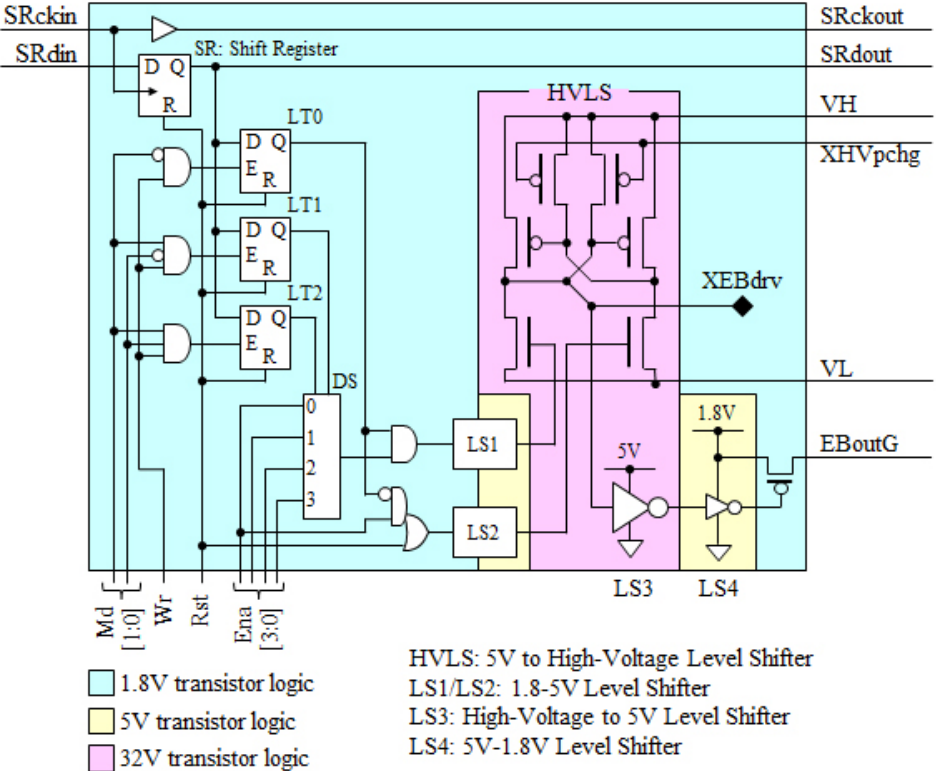
Figure 16. Circuit of one cell in the 100 × 100 active matrix driving LSI.